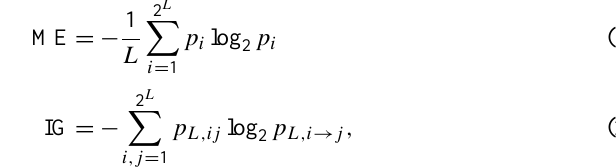
Fig.6. (a)Comparisonofensemblesoilmoisturesimulationsagainstobservations. Thecyanshadingindicates Fig. 6. (a) Comparison of ensemble soil moisture simulations the ensemble spread, shown as ± 2 × ensemble standard deviation (b) The uncertainty importance of model against observations. The cyan shading indicates the ensemble parameterstowardssoilmoistureuncertainty. spread, shown as ± 2 × ensemble standard deviation. (b) The uncer- tainty importance of model parameters towards soil moisture uncer-